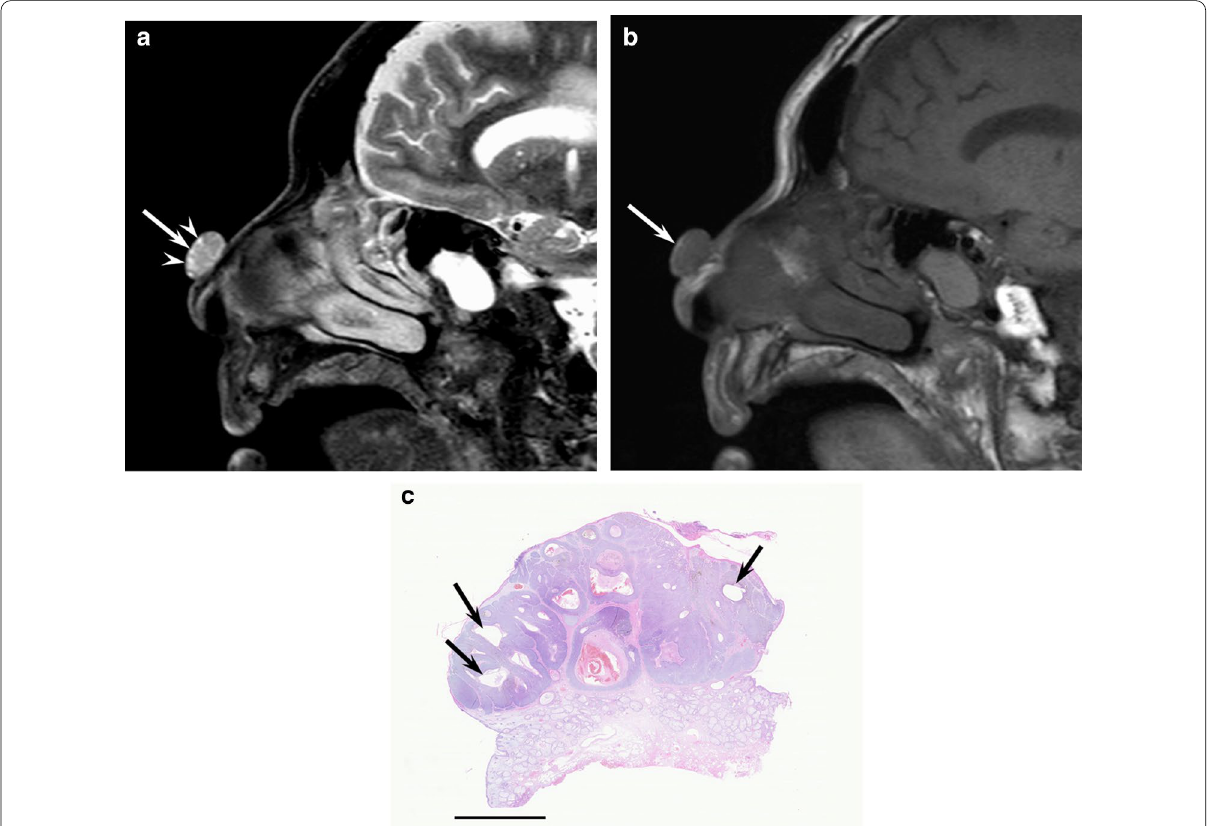
Fig. 2 An 86‑year‑old male with basal cell carcinoma on the nose. a Sagittal fat‑suppressed T2‑weighted image showing an elevated oval mass (arrow) with cystic foci (arrowheads). b Sagittal T1‑weighted image showing an oval mass (arrow). c Histological specimen (H&E stain; scale bar, 5 mm) showing a well‑defined mass in the dermis with multiple cystic cavities with mucinous contents